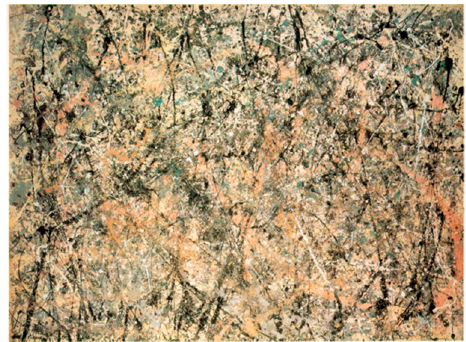
Figure 2. Jackson Pollock, Lavender Mist: Number 1 , 1950 , 1950, oil, enamel, and aluminum paint on canvas, 87 × 118 in. (221 × 299.7 cm). National Gallery of Art, Washington, D.C. Ailsa Mellon Bruce Fund. © 2022 The Pollock-Krasner Foundation/Artists Rights Society (ARS), New York .